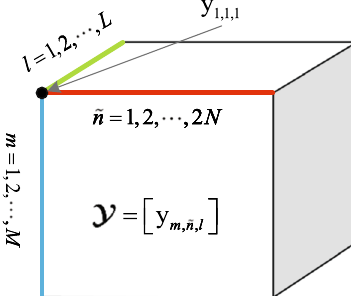
Fig. 2 The M × 2 N × L tensor for polarimetric FDA-MIMO